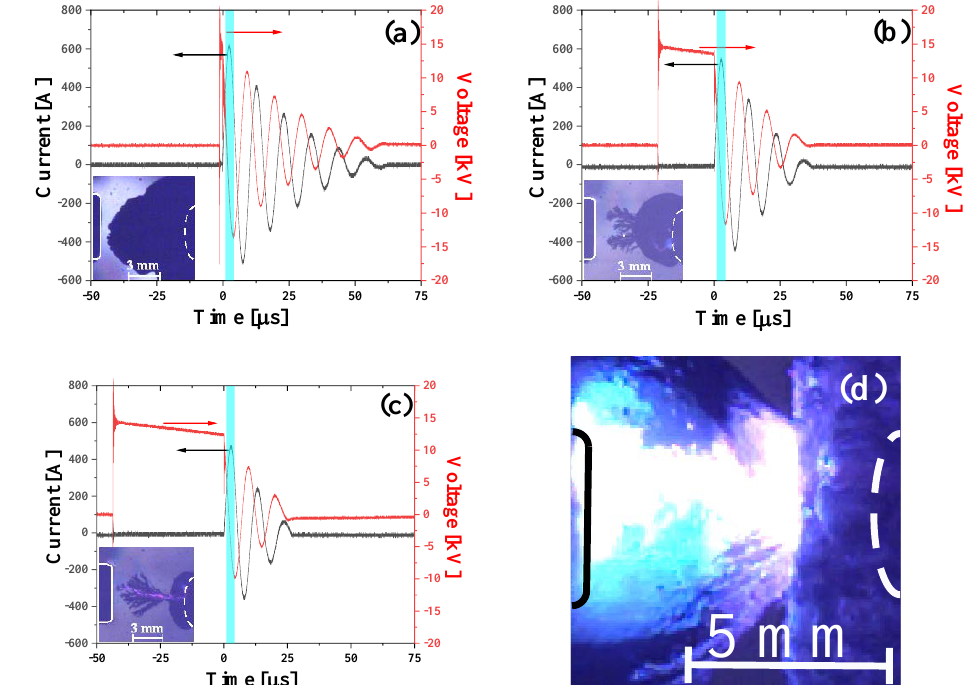
Figure 3. ( a – c ) Temporal voltage and current waveforms of underwater discharges initiated in nitrogen bubbles of different sizes. Insets in images show the images of the injected nitrogen bubble just before the breakdown (exposure time 0.4 μs); the surface of the anode is outlined by a white solid line, while the white dashed line depicts the cathode surface; the cyan area represents the exposure time period during which the optical emission spectra were measured. ( d ) Spark generated in nitrogen bubble identical to the discharge shown in image ( a ) captured 48 μs after the gap breakdown (exposure time 0.4 μs); black solid line contour shows the anode surface, and white dashed line shows the cathode surface.